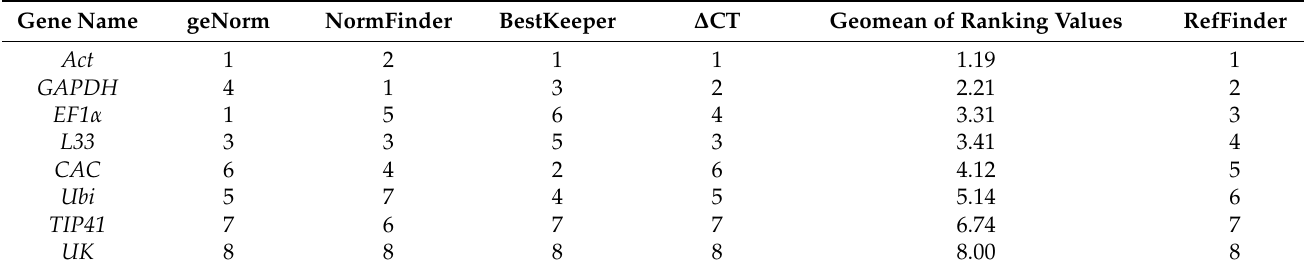
Table 6. Ranking of stability of reference genes in ‘MM’ subdataset.